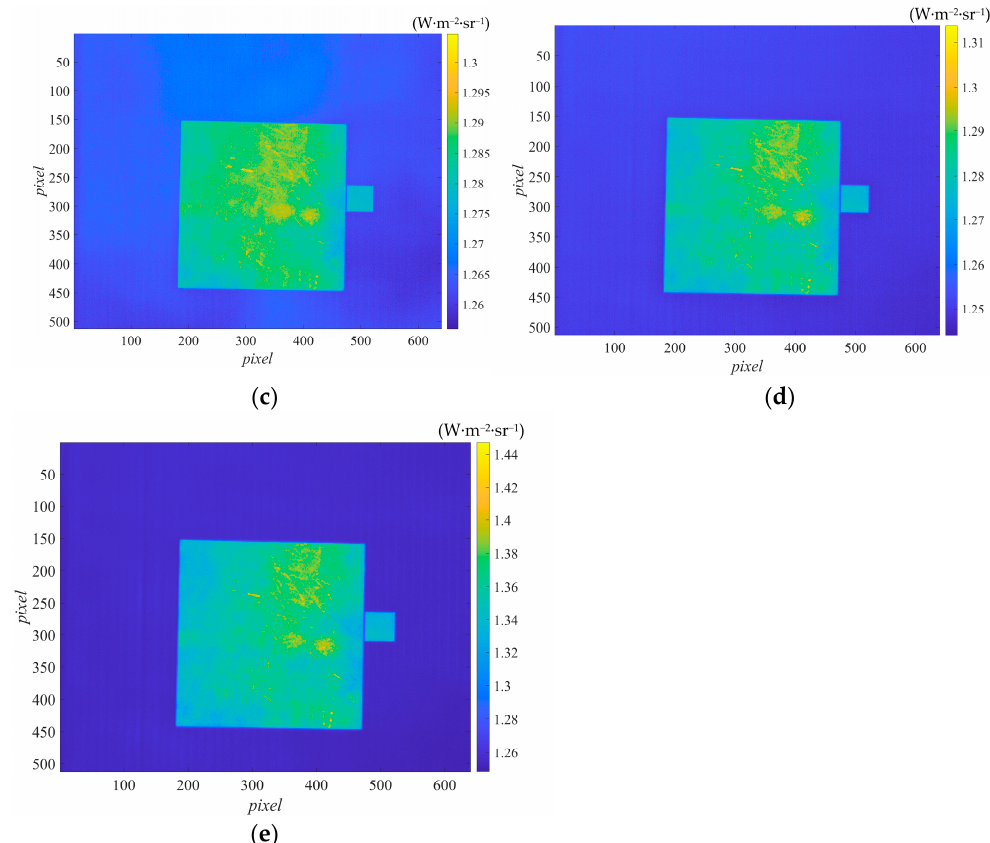
Figure 4. Radiance images output by the thermal imager at the five irradiation energies. ( a – e ) corresponded to the radiation source temperature of 50, 75, 100, 125, 150 °C, respectively.